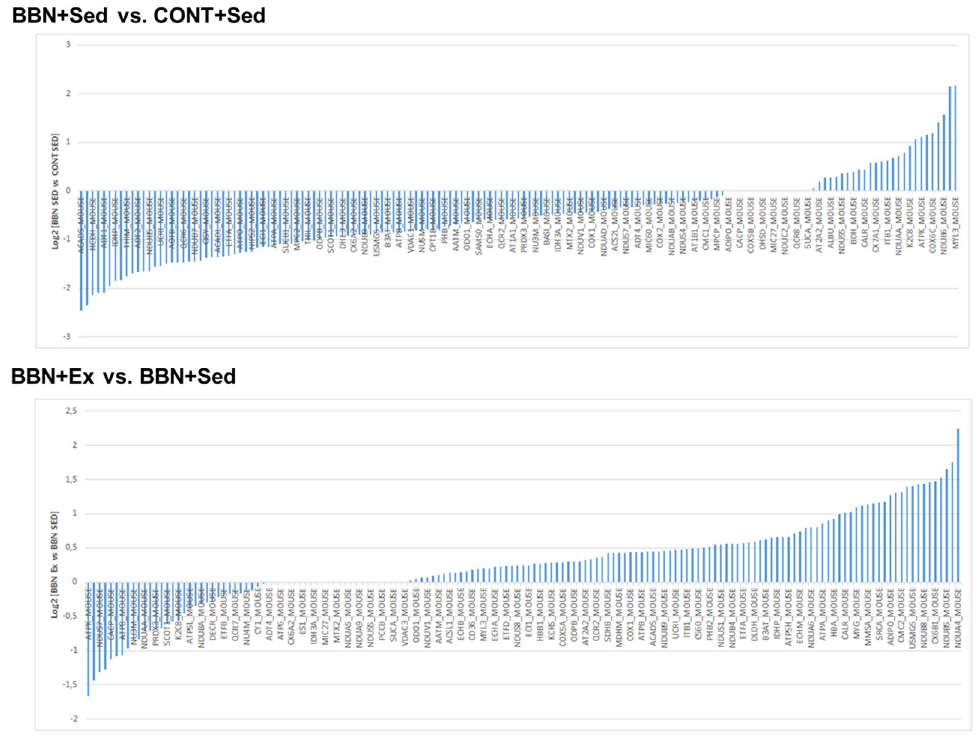
Figure 5. Normalized abundance of proteins in BBN+Sed vs. CONT+Sed and BBN+Ex vs. BBN+Sed groups. Proteins with log2 lower than 0.05 are not presented in the figure but are listed in Supplementary Table S1. Protein accession numbers are correlated to protein names in Supplementary Table S1.